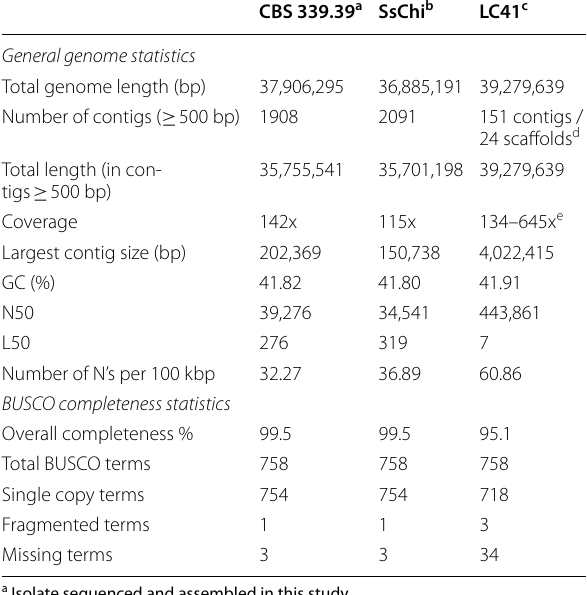
Table 1 The main metrics of the three available genome sequences of Sclerotinia